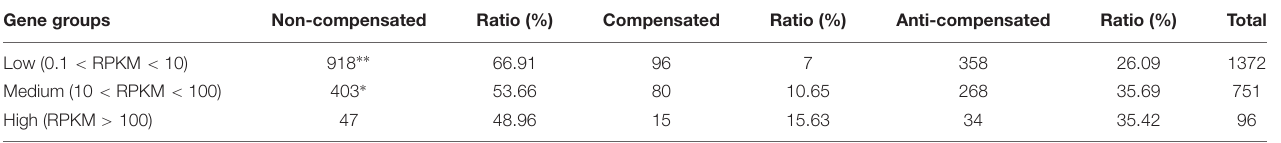
TABLE 4 | The relationship between gene expression level and gene expression compensation.